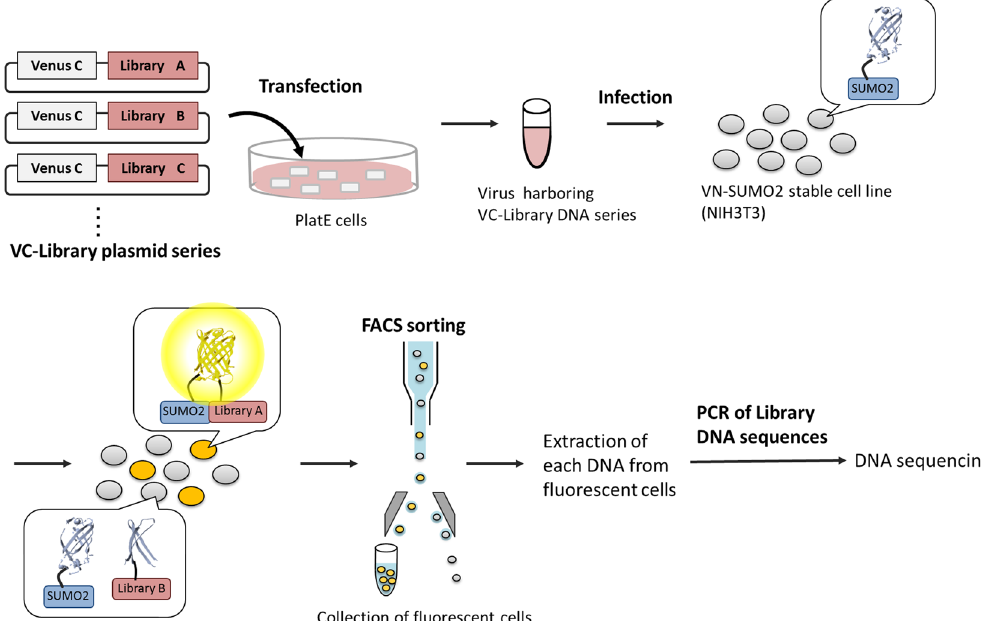
Figure 3. Schematic of screening mammalian SUMOylated proteins based on the reconstitution of split Venus fragments. Library DNAs are inserted into virus infection vectors with DNA of VC fragment and transfected into PlatE cells. The produced viruses harboring VC-library DNAs are added to NIH3T3 cells that stably express VN-SUMO2. The fluorescent cells harboring reconstituted Venus are sorted by FACS. The library DNA is extracted from each fluorescent cell. SUMOylated protein candidates are identified by an analysis of the extracted DNA sequences.